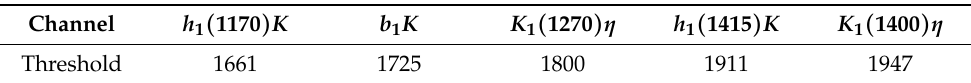
Table 4. J P = 1 − meson–meson channels with I = 1/2. The threshold masses are in the units of MeV. Here, the flavor-neutral axial vector mesons have J PC = 1 + −